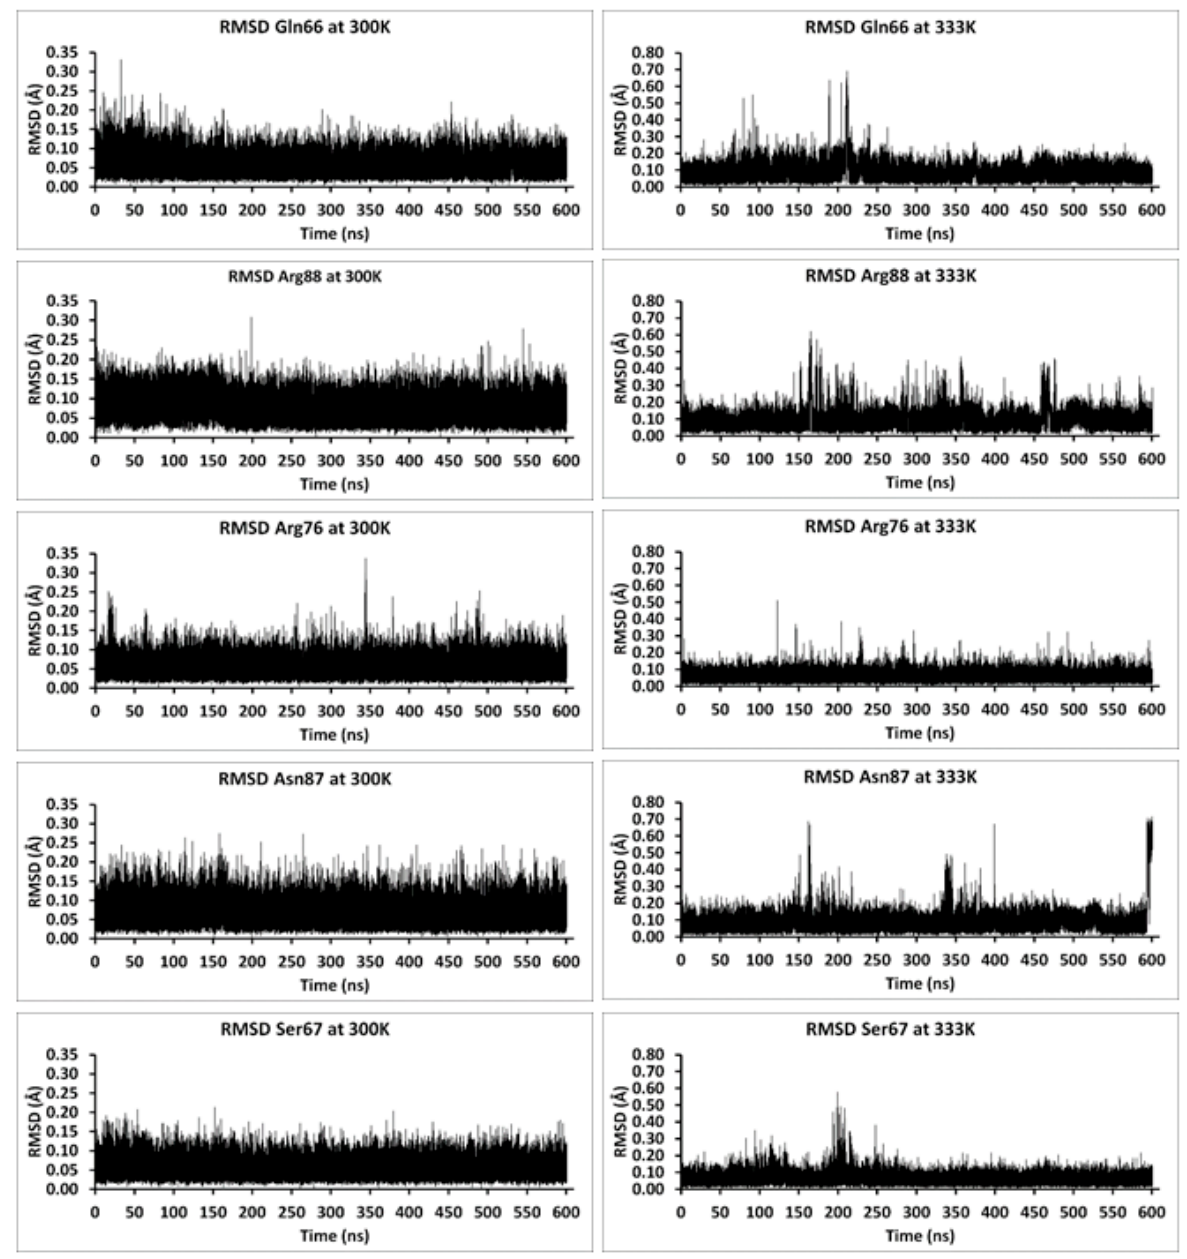
Figure 3. Plots of the Root Mean Square Deviation (RMSD) of Gln66, Arg88, Arg76, Asn87, and Ser67 residues over the course of the continuous 600.5 ns MD simulations of the P450-TT enzyme performed at 300 K and 333 K.